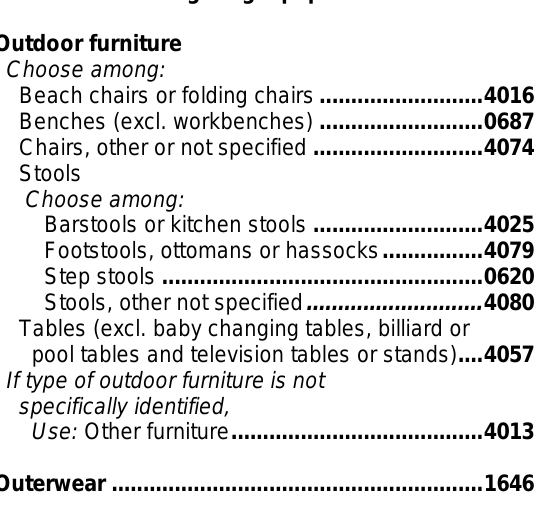
Tables (excl. baby changing tables, billiard or pool tables and television tables or stands) ....